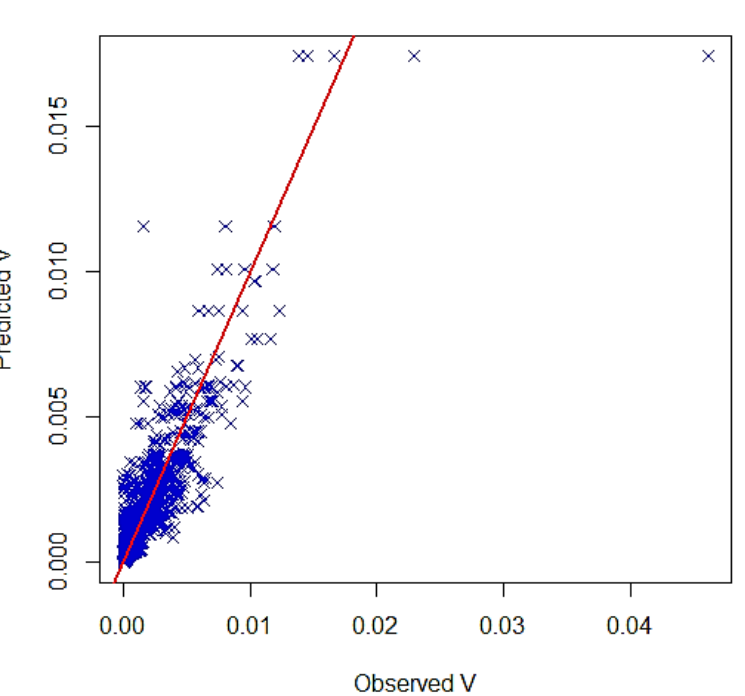
Figure 8. Comparison plot of predicted and observed settling velocity for the SOFM model with a 25 × 25 Kohonen map.